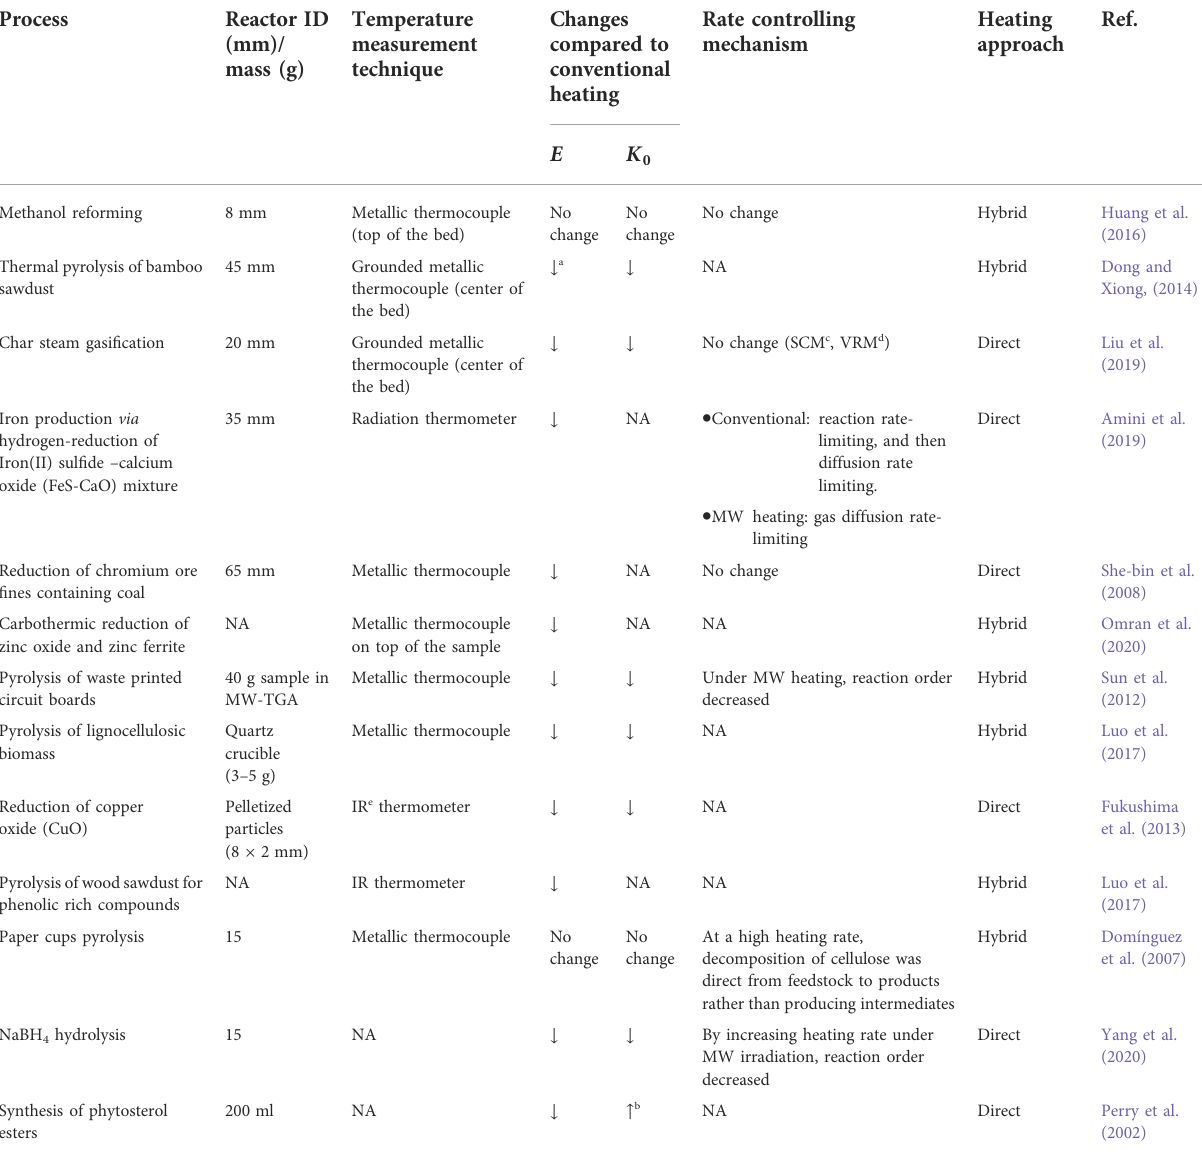
TABLE 2 kinetic studies of gas/liquid-solid systems under MW